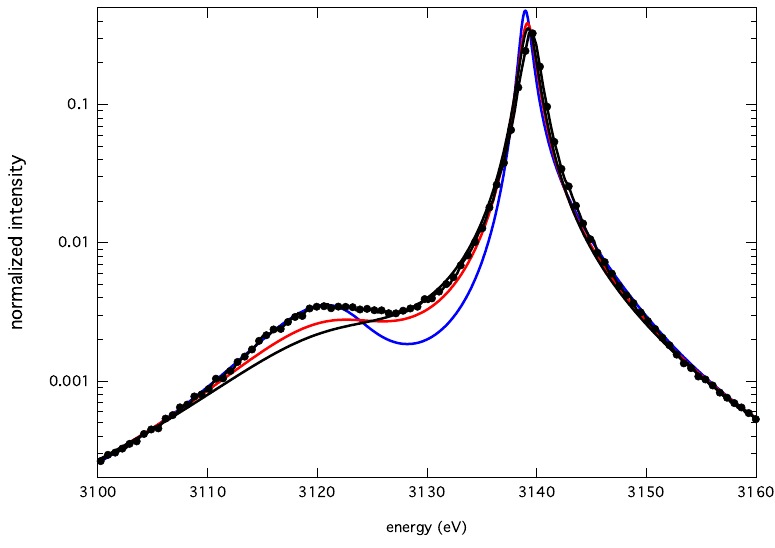
Figure 10. The He- (cid:11) line, the strong component for T = 1 keV and n SimU (black circles); FFM with (cid:23) = 3 eV (solid blue); (cid:23) = 5 : 62 eV (solid red); and (cid:23) = 8 eV (solid black).